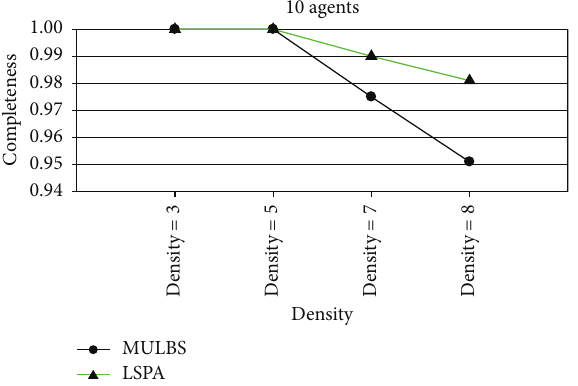
Figure 7: Completeness with 10 agents and densities 3, 5, 7, and 8.